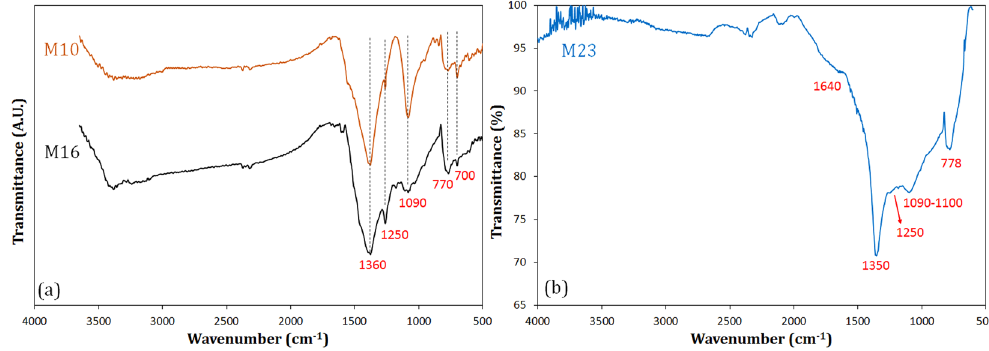
Figure 3. FTIR spectrum of sample M23 after combustion and the leaching treatment.